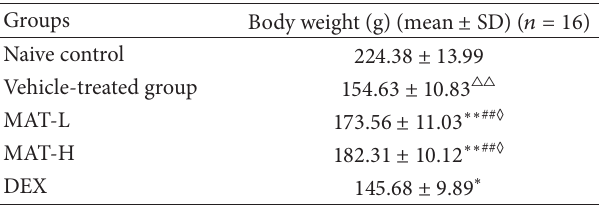
Table 1: Mean maximum clinical scores and body weight on day 17